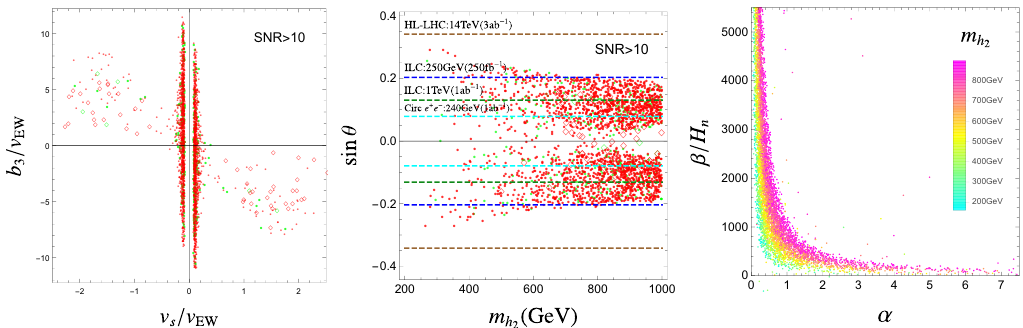
Figure 6 . Points depicted here pass all phenomenological constraints and give successful bubble nucleations, along with detectable GWs at LISA (SNR > 10). We show them in the planes of the input parameters: in plane ( b 3 ; v s ) =v EW (left) and (sin (cid:18); m h points which give SNR > 50 (red) with those of 50 > SNR > 10 (green) in these two plots. The right panel shows all the points in the plane ( (cid:11); (cid:12)=H n ) with the colors denoting the values of m h as shown in the